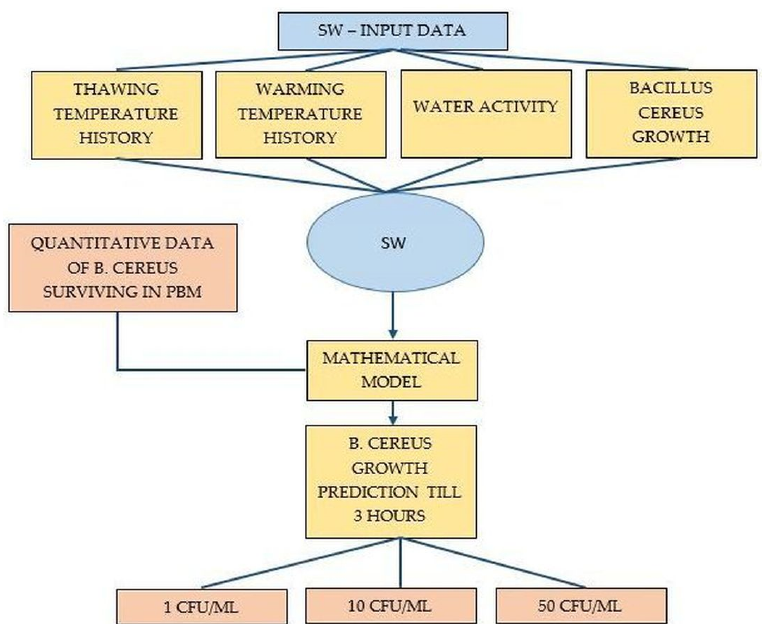
Figure 2. Schematic design of the experiment.